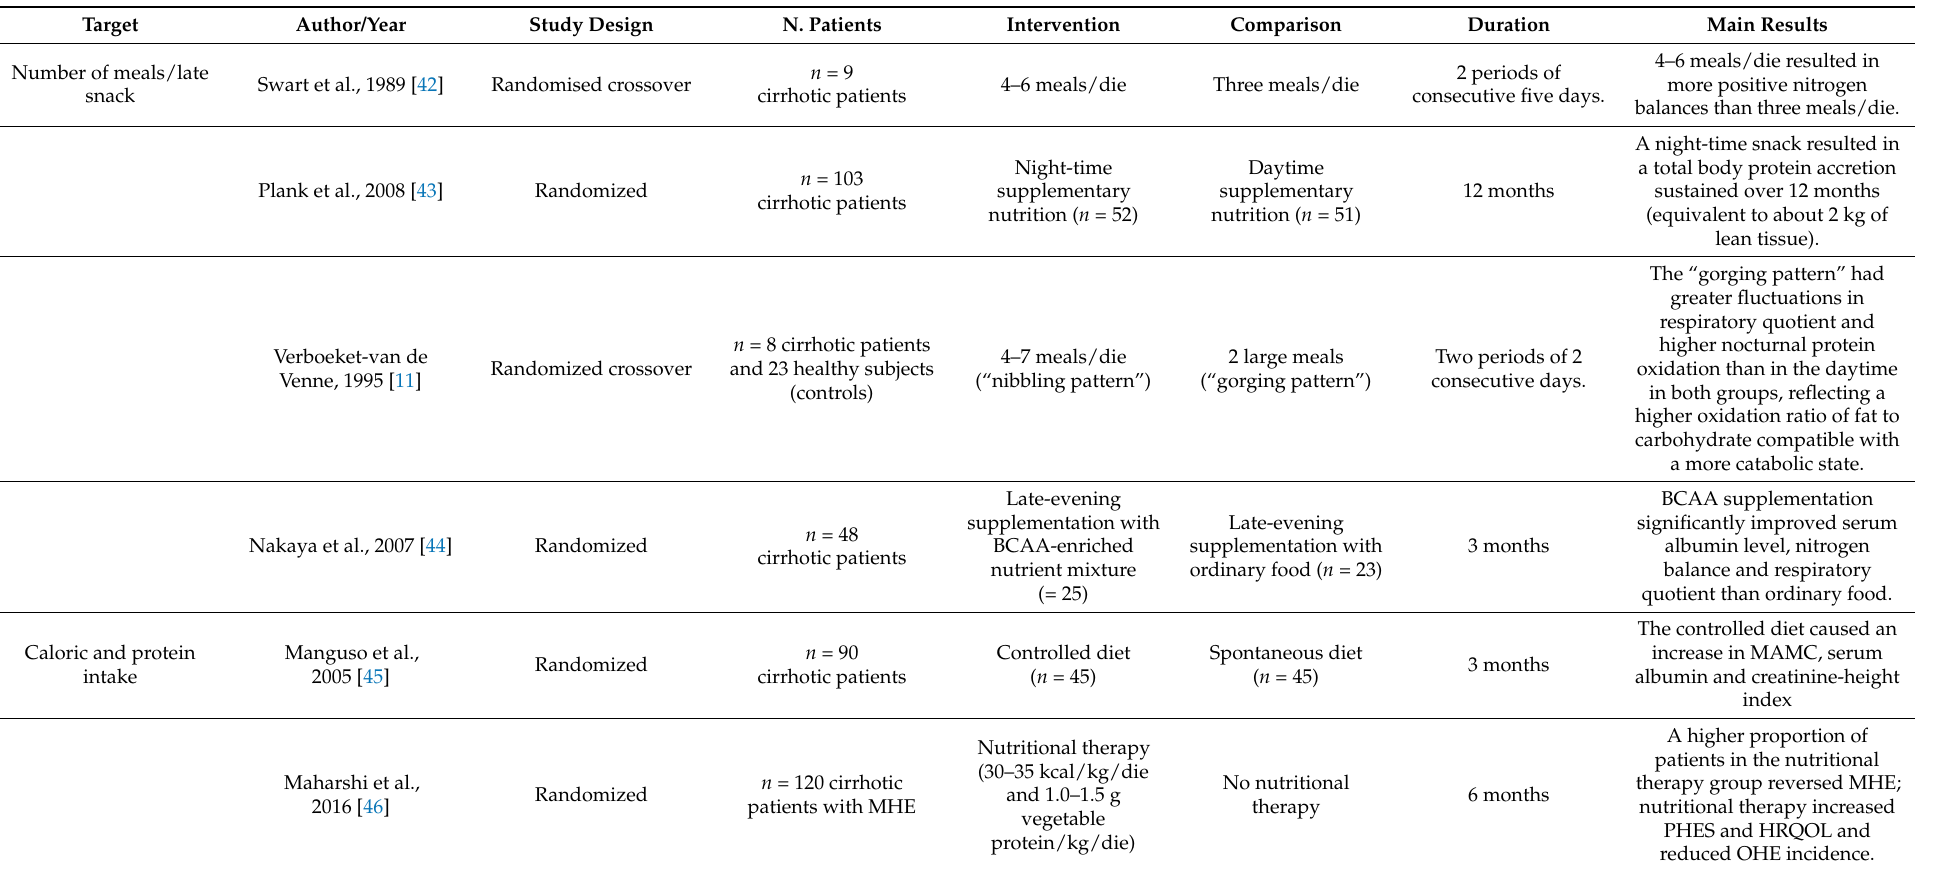
Table 2. Published studies on dietary interventions and exercise in patients with liver